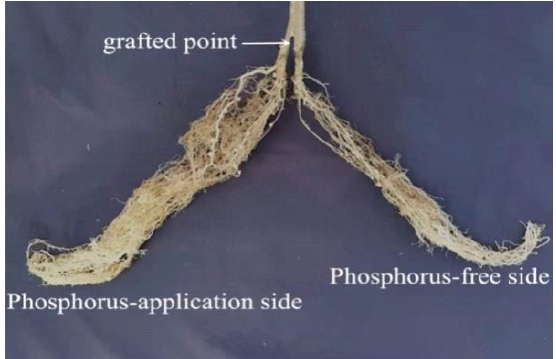
Figure 1. Roots of dual-root soybeans.